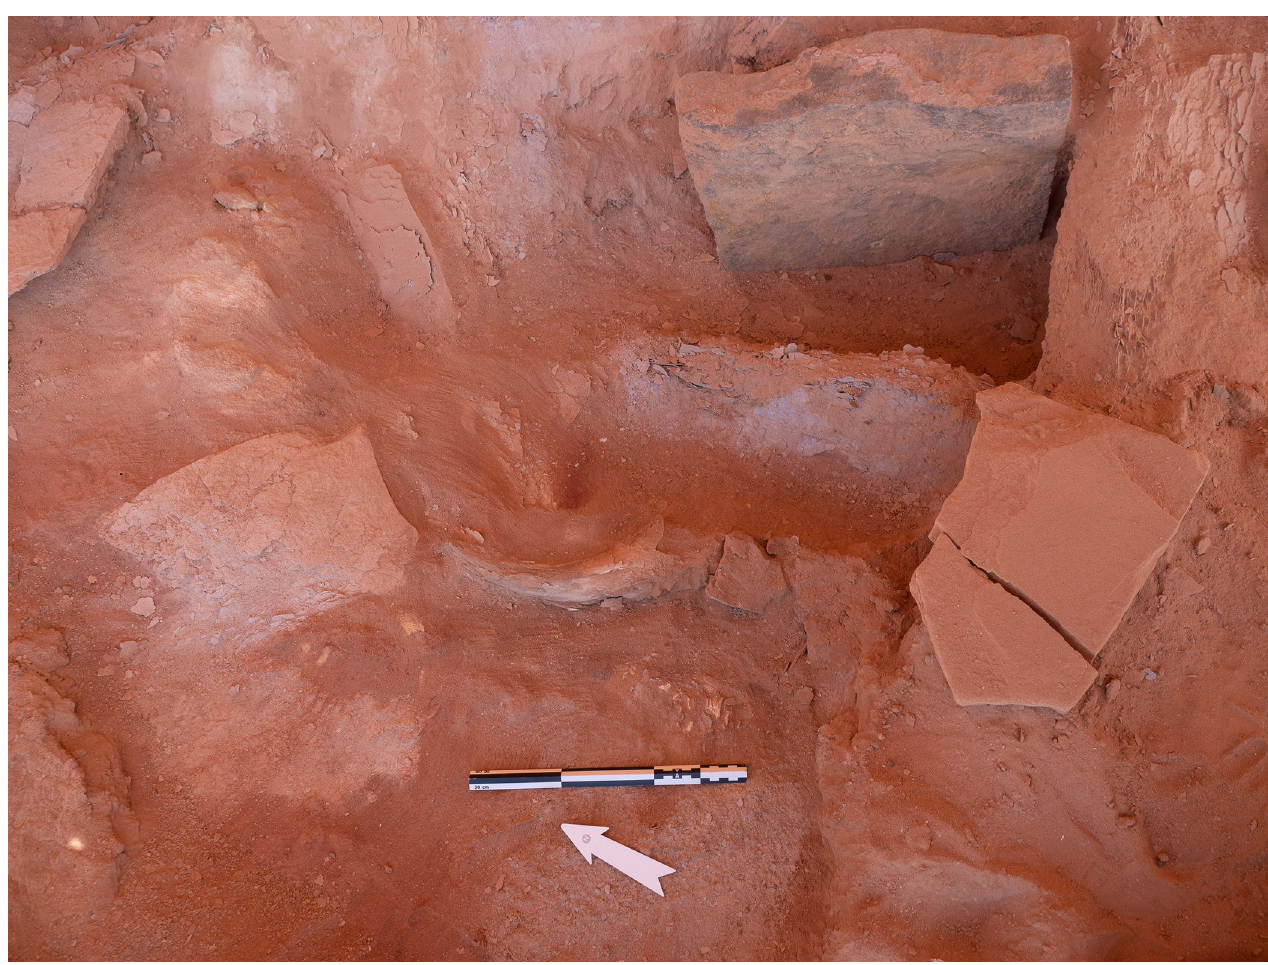
Fig 12. Bos sp. horn (#0032) recovered from Phase 4A, note the positioning in relation to up-right stone A.